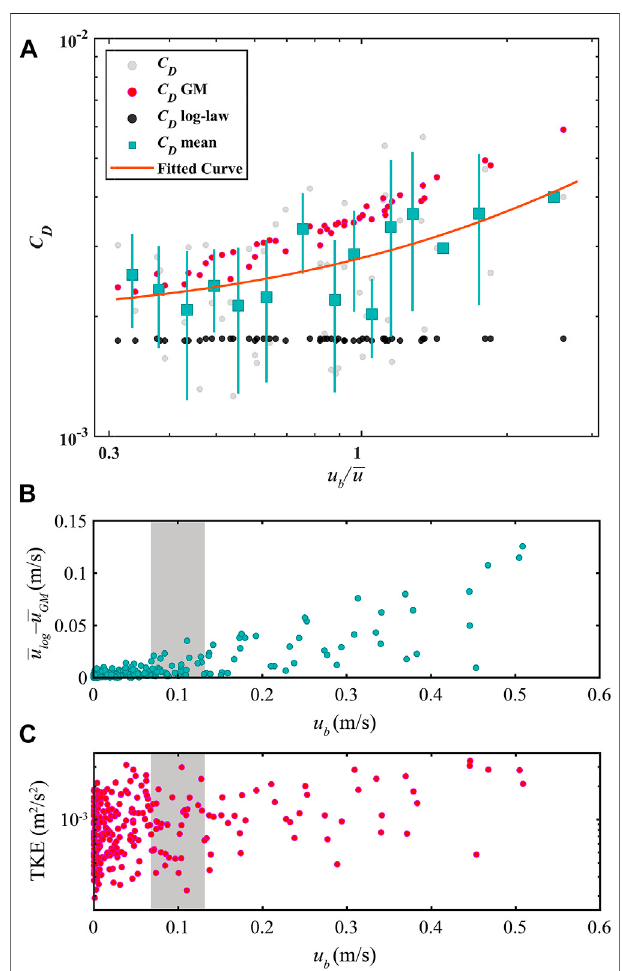
FIGURE 13 | (A) Scatter plots of C D verses u b / (cid:1) u when u b > 0 . 1 m/s for S3andS5inwinter.Graydotsindicatedirectlyobserved C D ,reddotsindicate C D calculated by the Grant-Madsen model, black dots indicate C D calculated by log-law, blue squares are the bin averages of observed C D , and vertical lines indicate standard deviation. The best fi ne line observed C D is shown in orange. (B) The difference (cid:1) u calculated bythe log-law velocity pro fi le ( (cid:1) u law ) and the Grant-Madsen model ( (cid:1) u GM ) and (C) turbulent kinetic energy (TKE) as a function of u b